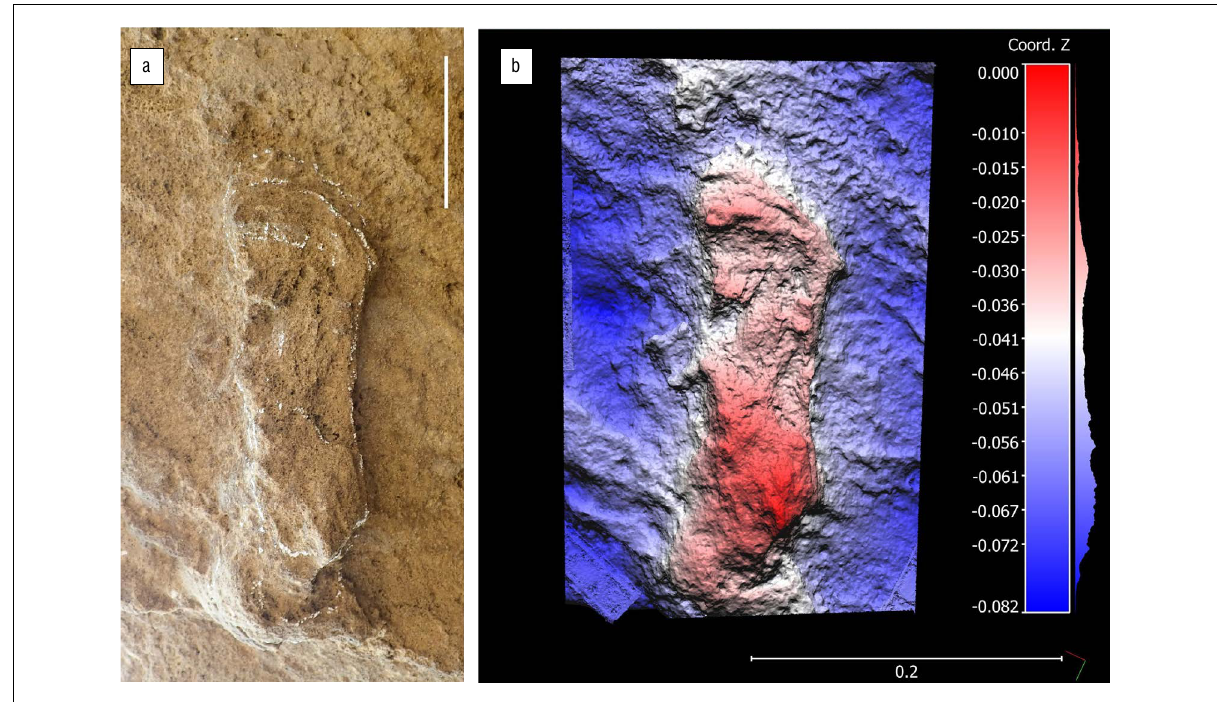
Figure 5: (a) Track G, lightly outlined in white chalk. White horizontal scale bar = 10 cm. (b) Photogrammetry colour mesh of Track G, using 59 images. Photos were taken an average of 34.2 cm from the surface. The reprojection error is 0.554 pix. Vertical and horizontal scales are in